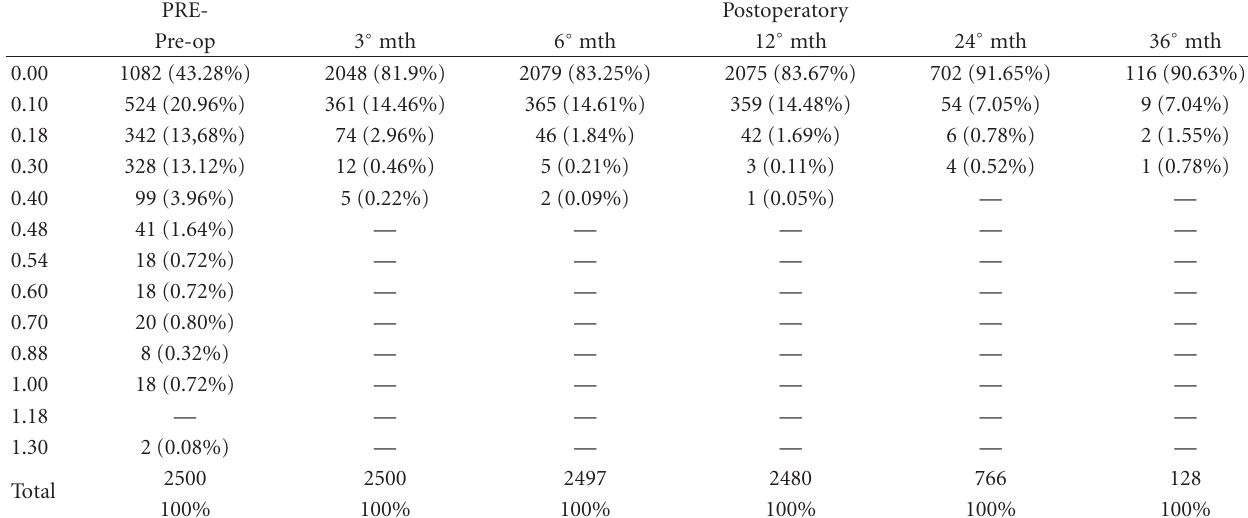
Table 3: CDVA in di ff erent periods during followup.